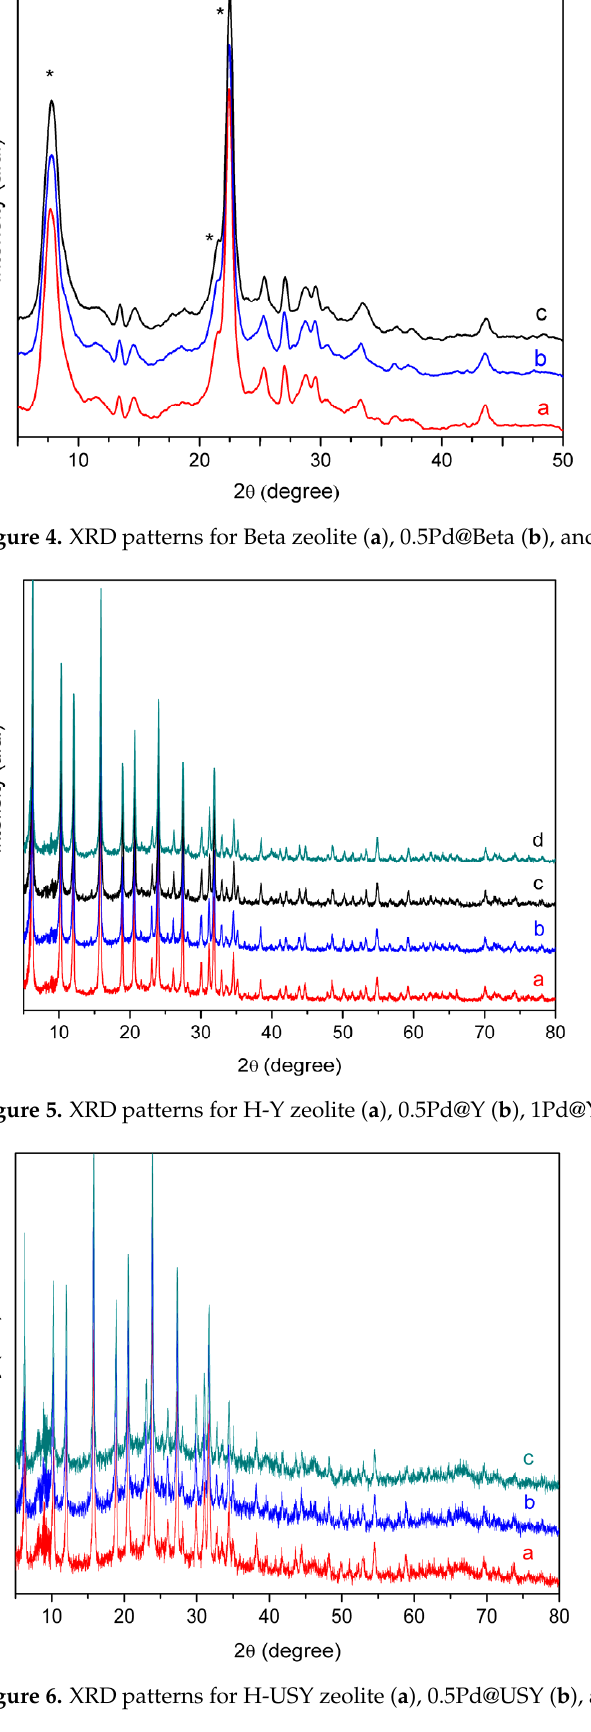
Figure 6. XRD patterns for H ‐ USY zeolite (a), 0.5Pd@USY (b), and 1.5Pd@USY samples.